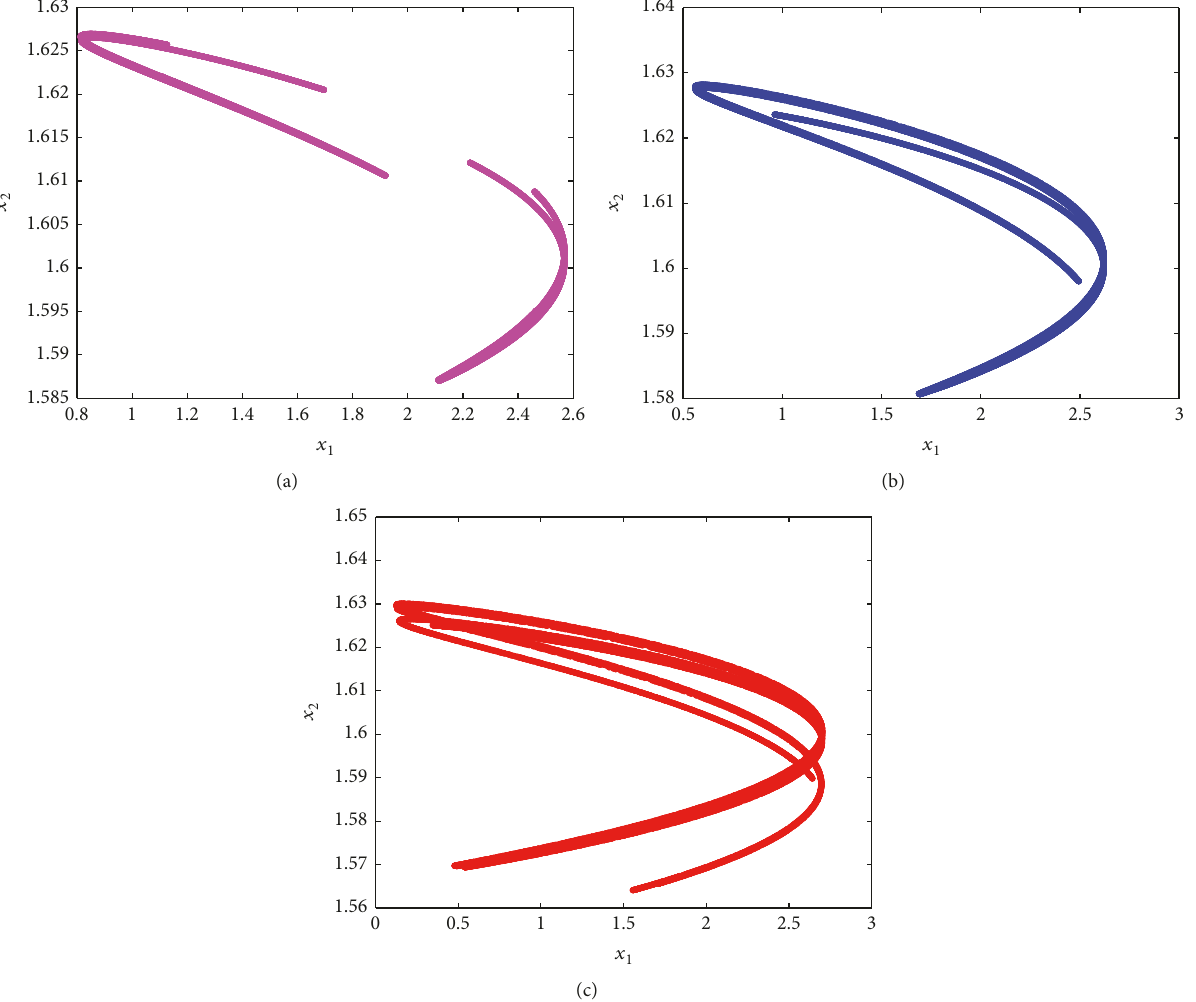
Figure 5: Chaos attractors of system (9) for (a) (𝛼 1 = 1.33, 𝛼 2 = 0.36) ; (b) (𝛼 1 = 1.39, 𝛼 2 = 0.36) ; (c) (𝛼 1 = 1.48, 𝛼 2 = 0.36) .